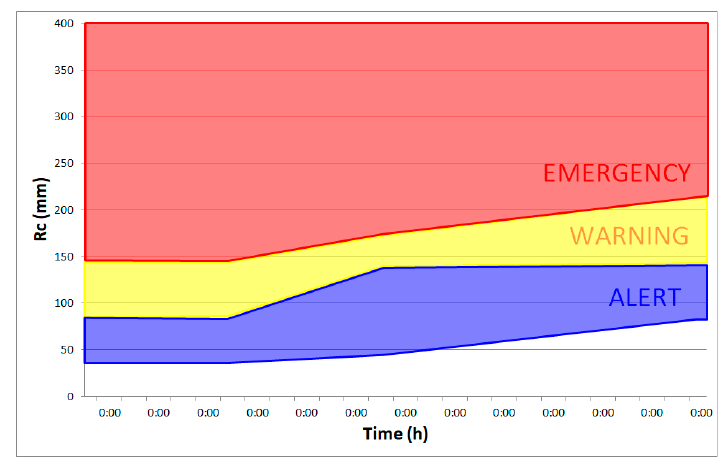
Figure 13. Debris flow Nomogram.